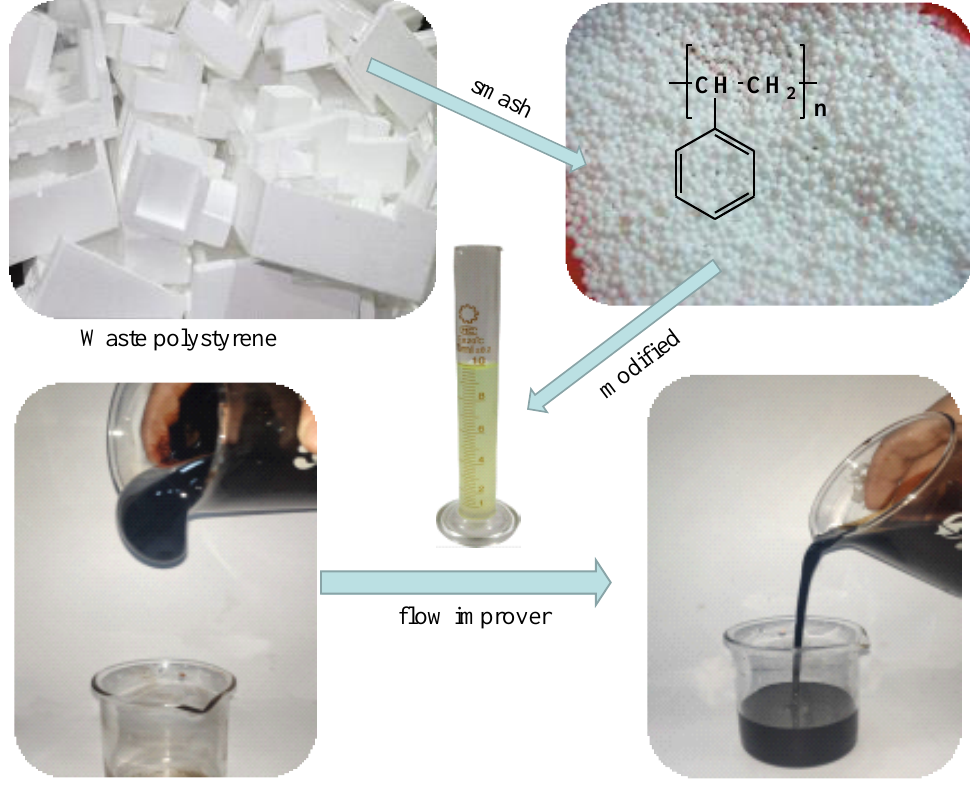
Figure 1. Application of waste polystyrene in viscosity reduction of crude oil.